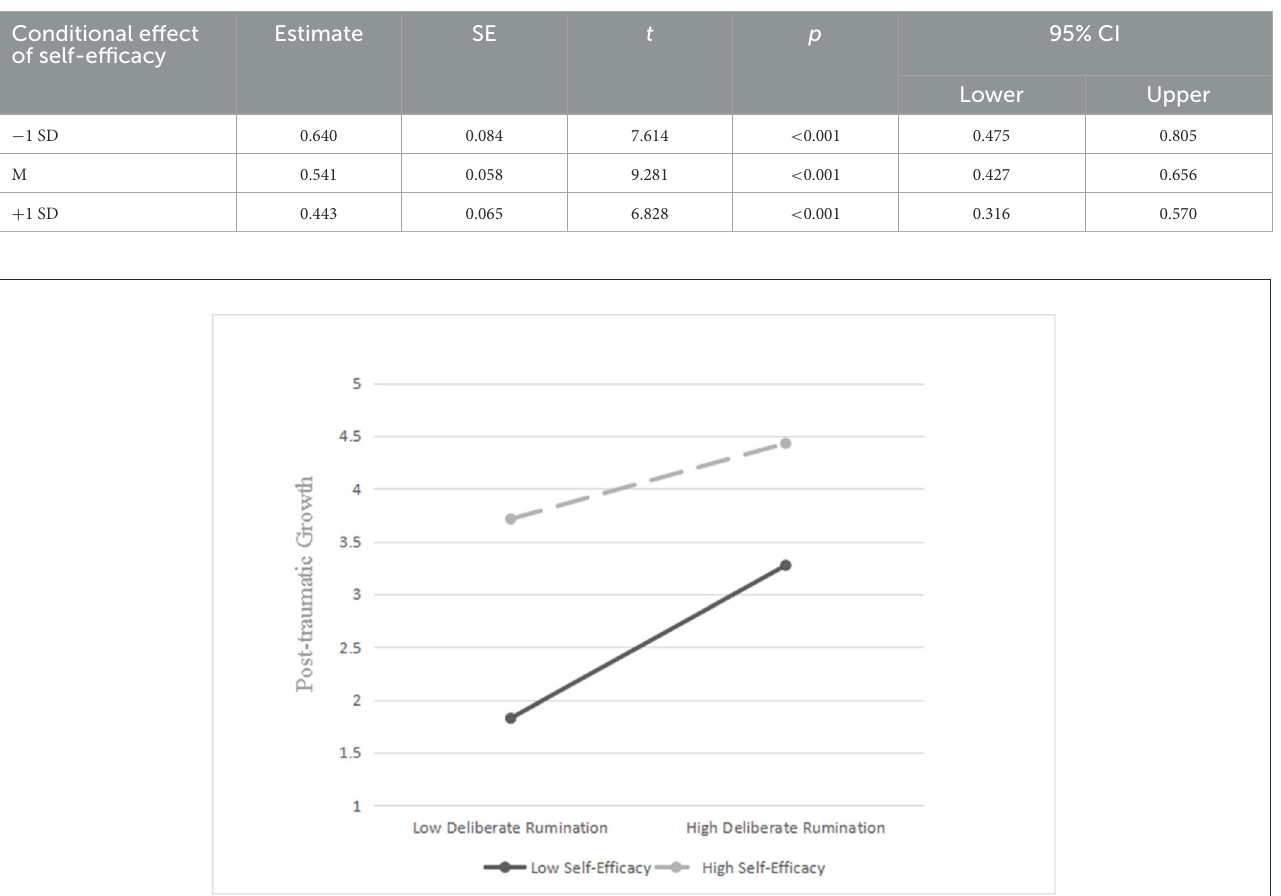
TABLE 4 Conditional effect at specific levels of deliberate rumination.